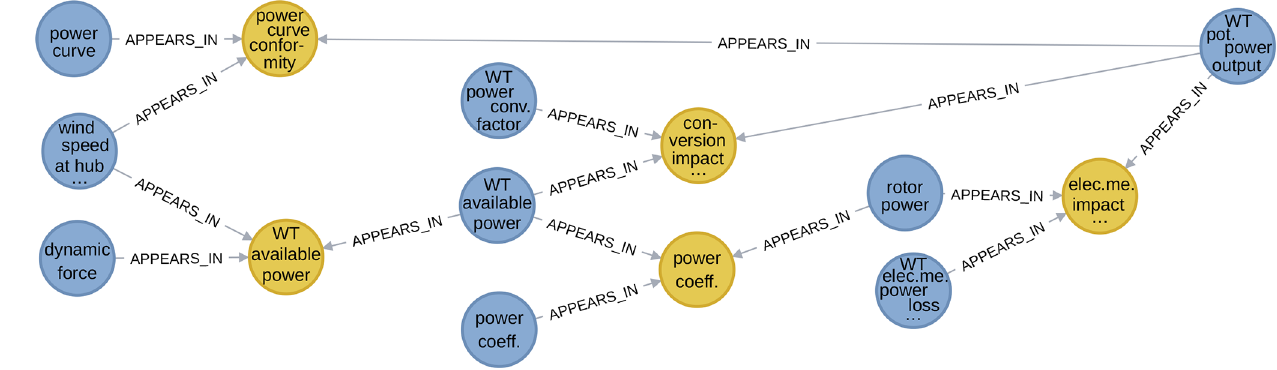
Figure 4. A simple WESgraph excerpt showing different pathways for computing the potential power output of a wind turbine (some edges omitted for